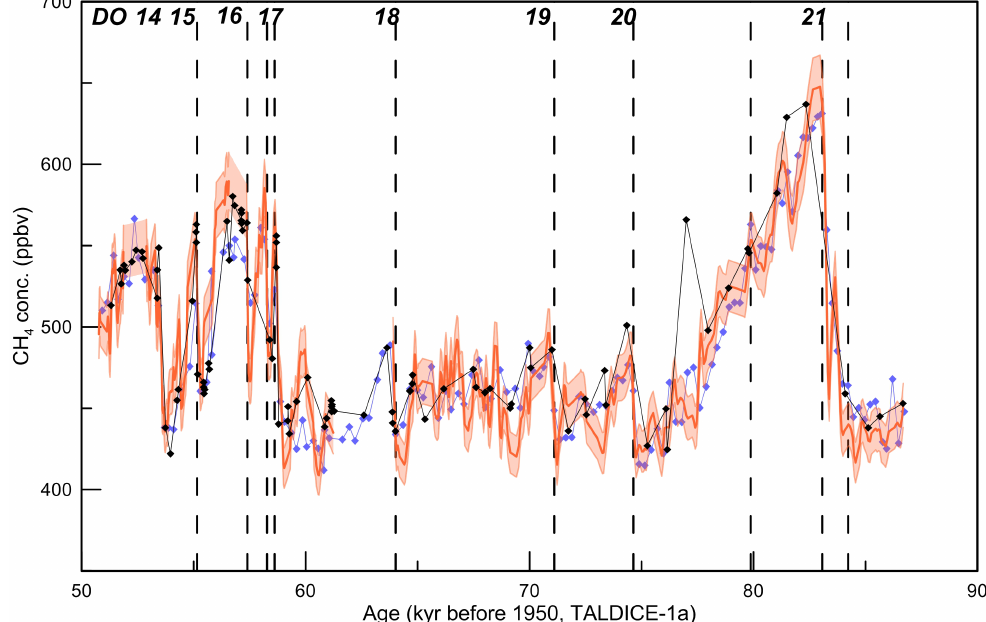
Fig. 2. The TALDICE CH 4 records (black diamonds: discrete data (Buiron et al., 2011); orange line: new high-resolution data with the light orange band indicating a ± 3% error band) plotted on the refined TALDICE-1a age scale in comparison with the EDC CH 4 record (blue diamonds) on the EDC3 age scale. Dashed lines indicate new tie points of the TALDICE-1a age scale; bold italic numbers indicate Dansgaard-Oeschger (DO) events.